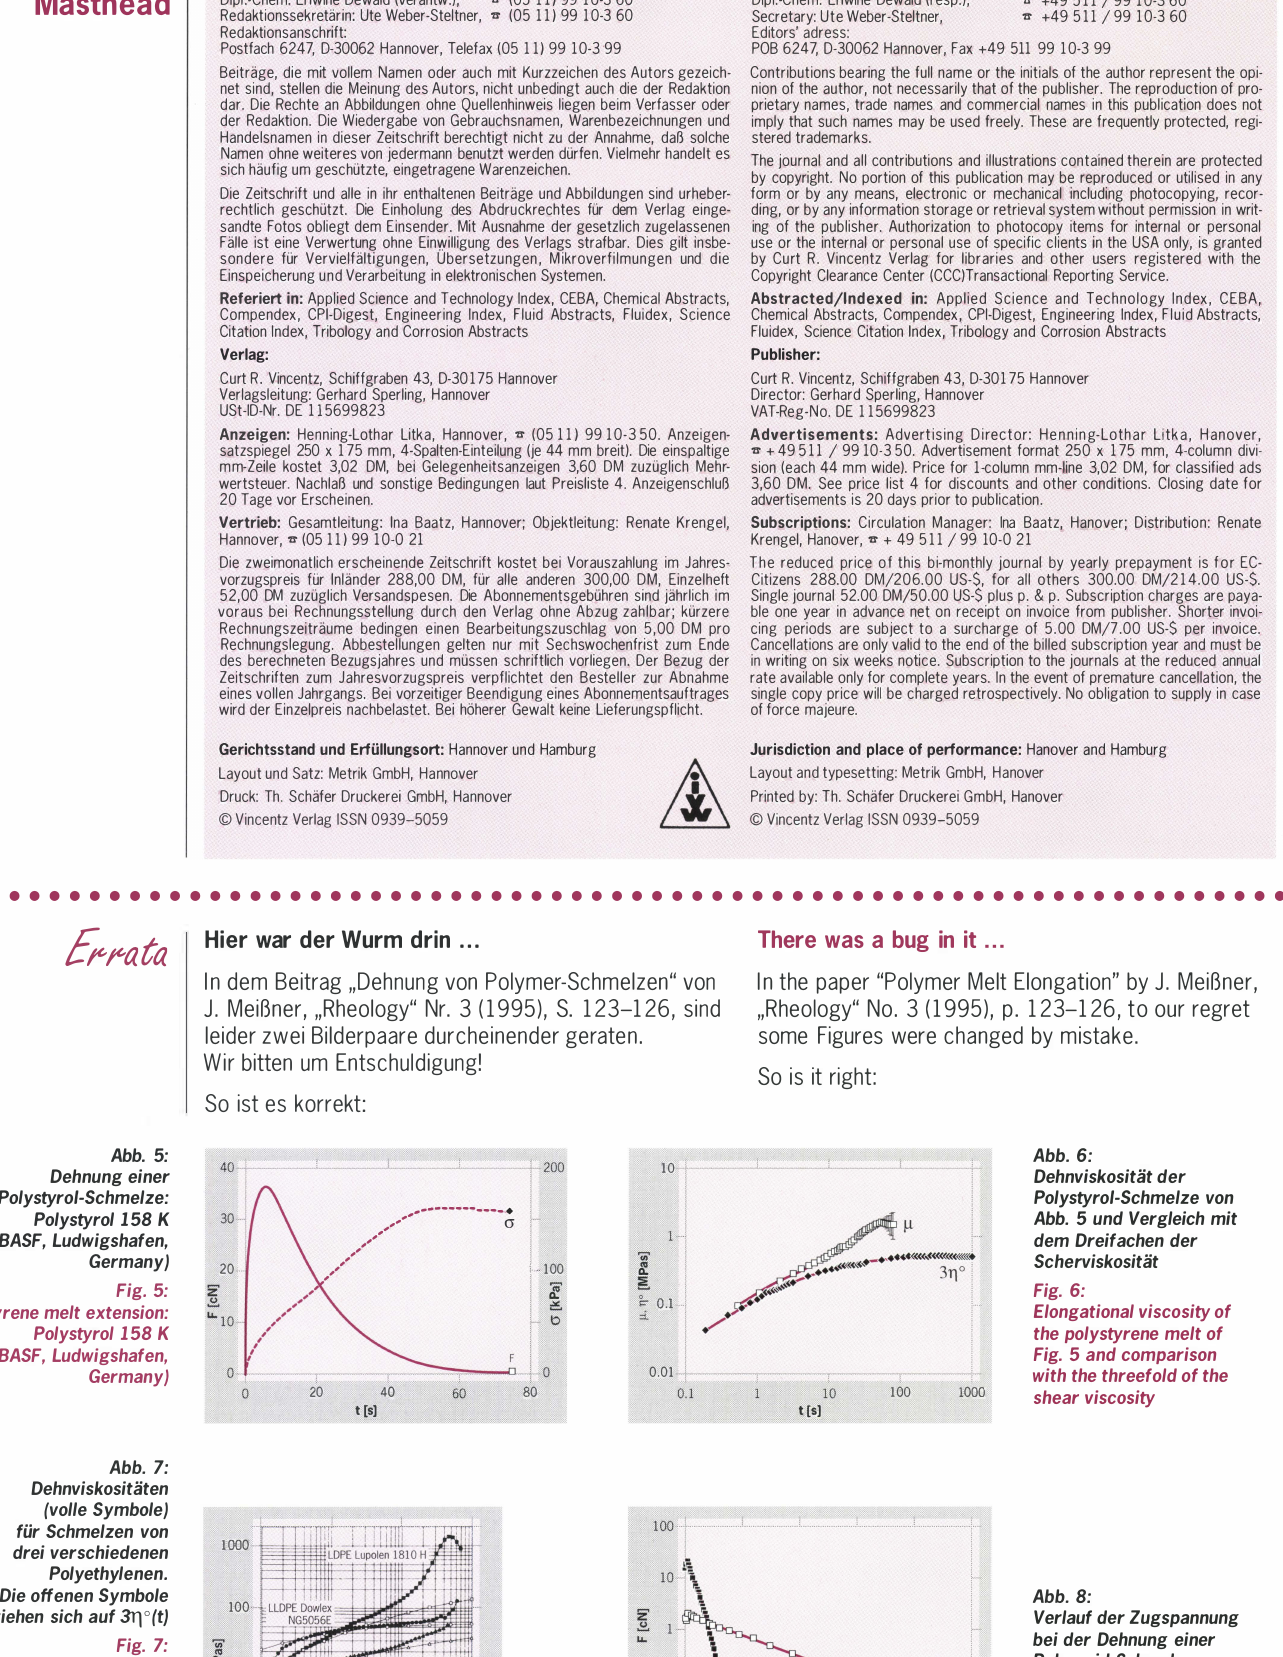
Fig. 8: Polyamide melt extension: Tensile force as a function of time (Uitramid 84 of